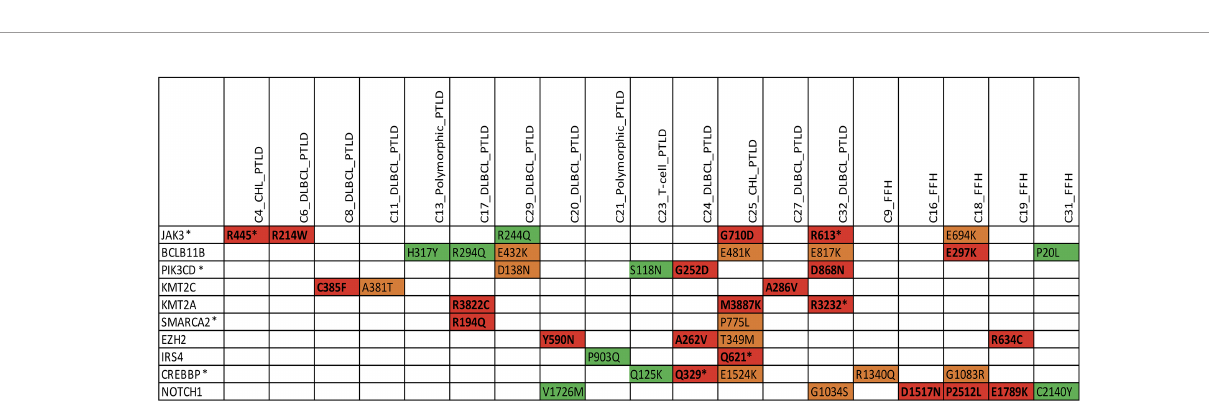
FIGURE 4 | Overview of somatic mutations in recurrently mutated genes in the mpc-PTLD and FFH-PTLD groups. Somatic mutations with a CADD score of >30 are shown in red, CADD score of 25-30 in orange, and CADD score of 20-25 indicated in green. *Genes affecting the JAK/STAT